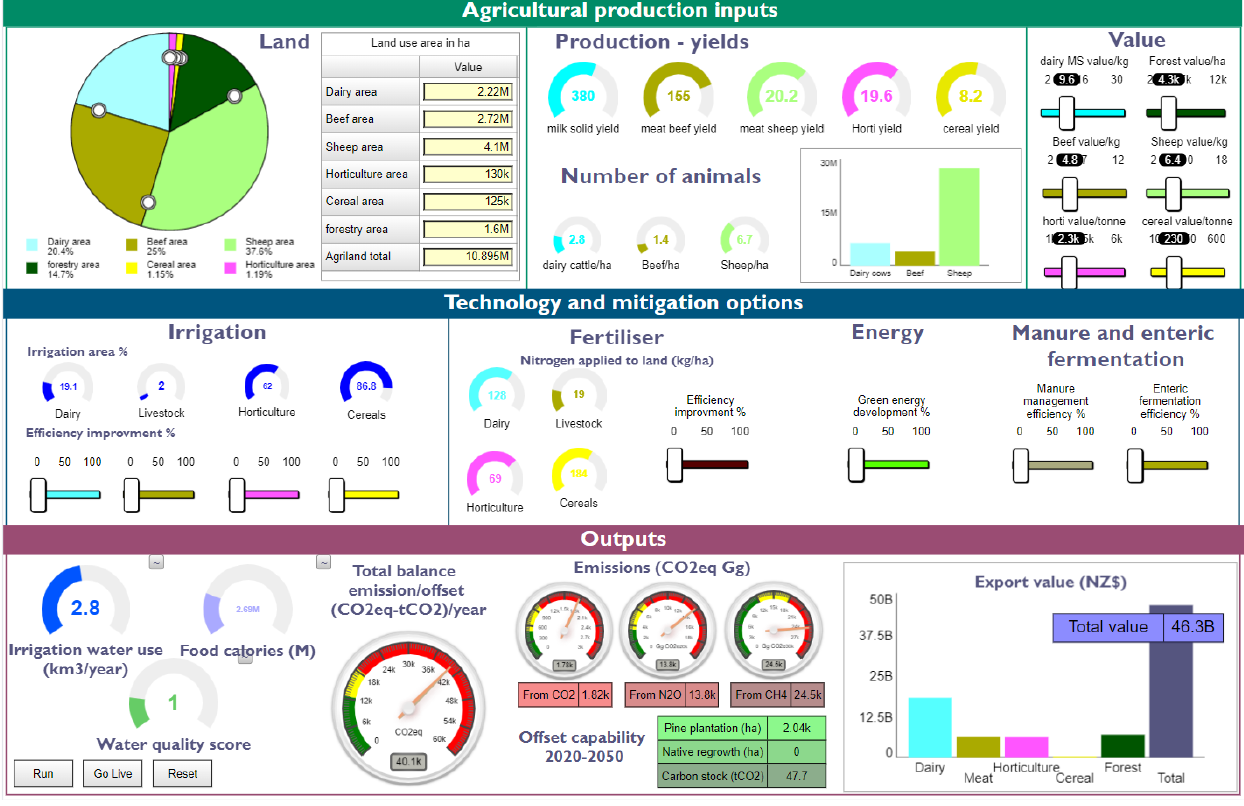
Figure 4. Model interface with agricultural production input values, selected technology, mitigation options, and outputs representing water use (km 3 /year), food calories, water quality improvement score, emissions, offsets, and export value for each sector. Minimum and maximum threshold values have been set to avoid unrealistic model outputs (Table 3). Table 3. Model input parameters thresholds.